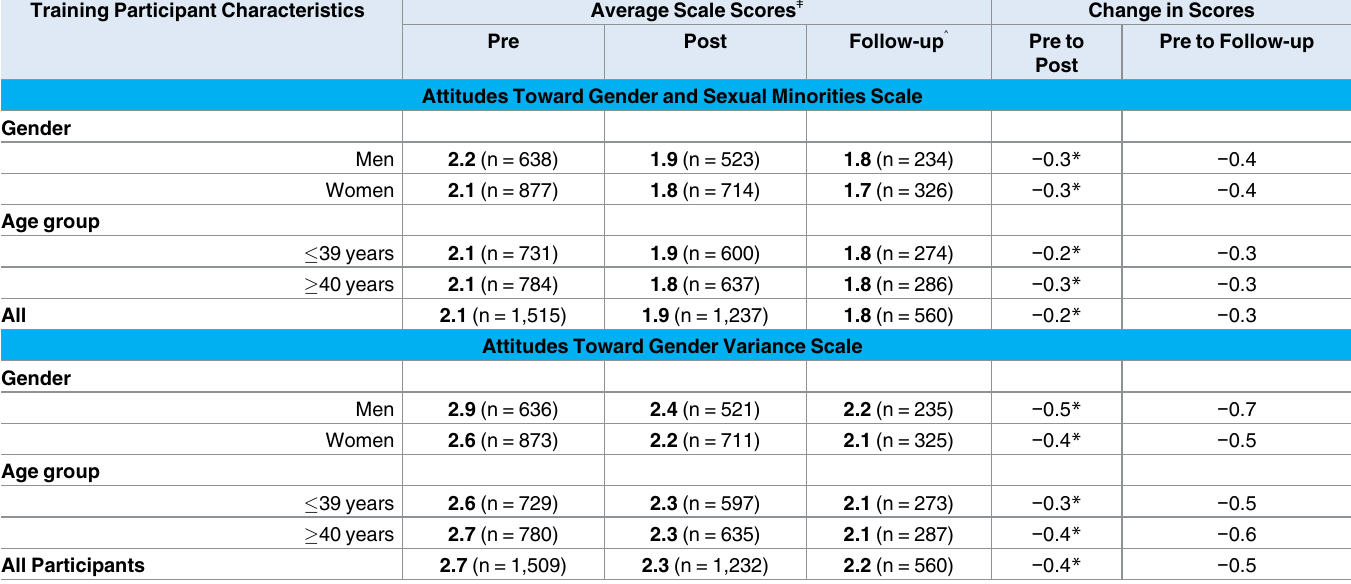
Table 4. Averagescale scores from pre-training, post-training, and 3–6 month follow-up. Training Participant